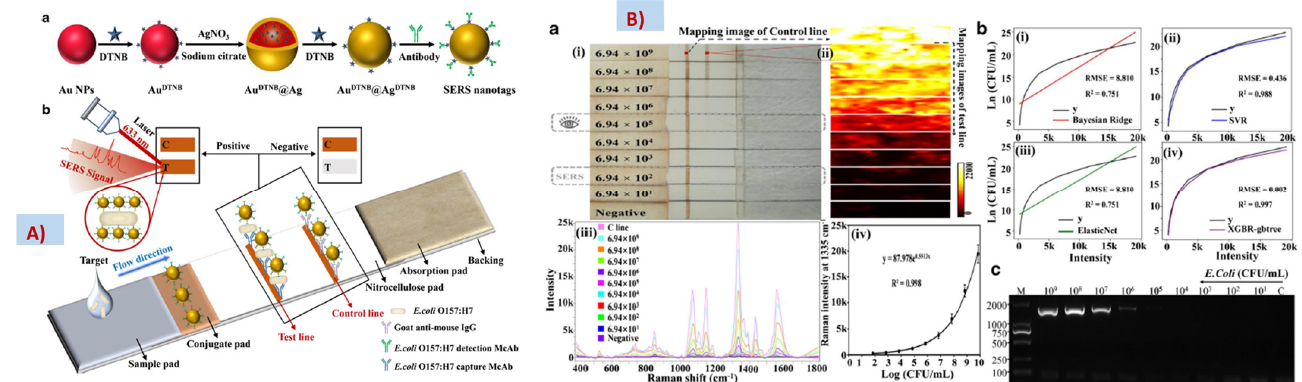
Figure 9. ( A ) Schematic of ML based quantification of E. coli O157:H7, using ( a ) SERS nanotags and ( b ) lateral flow assay along with different regression models, including SVR, BNR, and XGBR. Reproduced with permission from [392]. Copyright (2020), Springer. ( B ) ( a ) ( i ) Optical images of the lateral flow strips and ( ii ) SERS mapping region of the prominent peak in the SERS intensity profile. ( iii ) Corresponding SERS spectra of the test lines. ( iv ) Intensity and concentration fit. ( b ) Machine learning based regression fits for ( i ) Bayesian ridge regression (BRR), ( ii ) support vector regression (SVR), and the ( iii ) elastic net regression (ENR) and ( iv ) extreme gradient boosting regression (XGBR). ( c ) PCR image for the E. coli detection. Reproduced with permission from [392]. Copyright (2020), Springer.